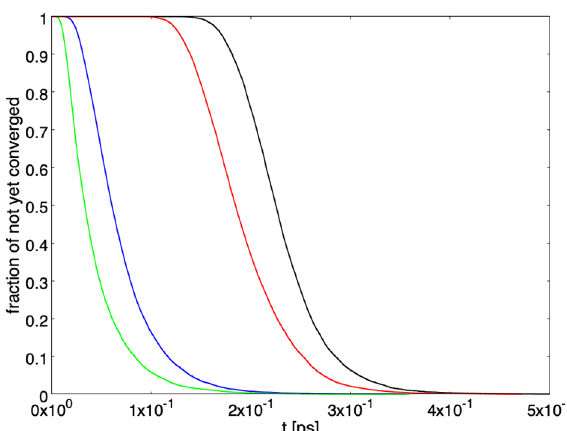
2 ≤ 1 − 𝜀 . The green and blue curves c R | |